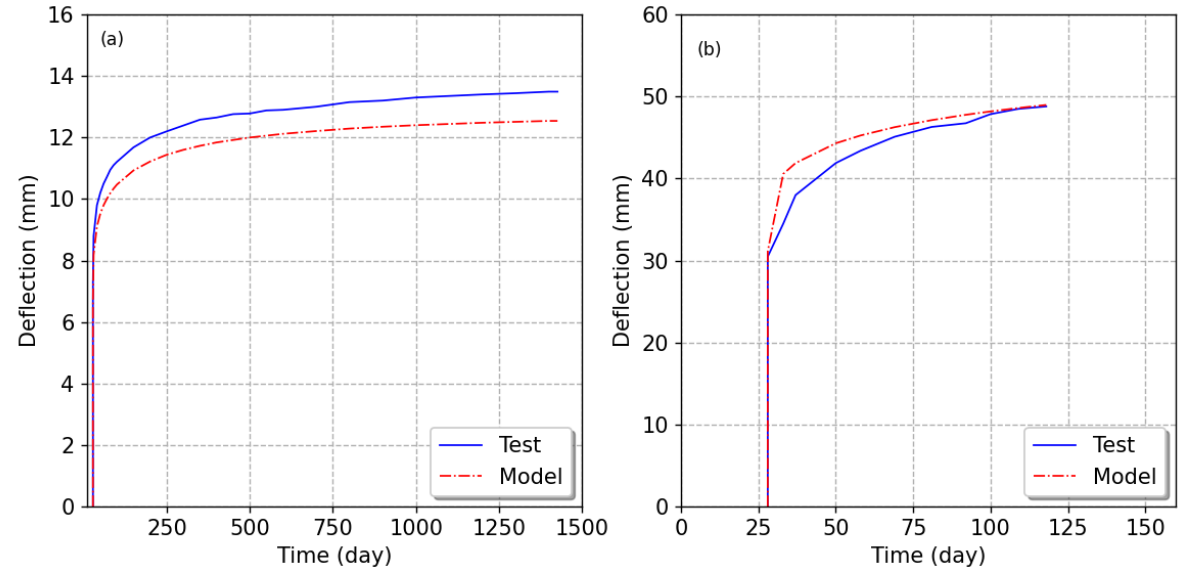
Figure 11. Time-deflection Diagram comparison: Experimental vs. Present Work; ( a ) Reybrouck et al. [10]; ( b ) Sryh and Forth [12].